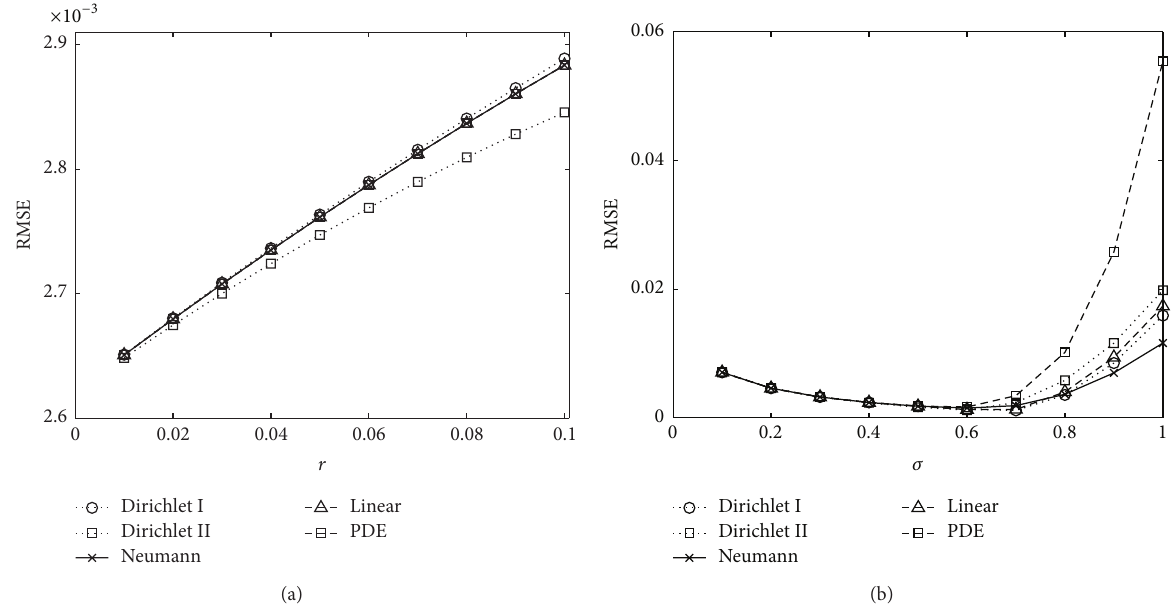
Figure 6: RMSE of various BCs versus (a) 𝑟 and (b) 𝜎 with cash-or-nothing